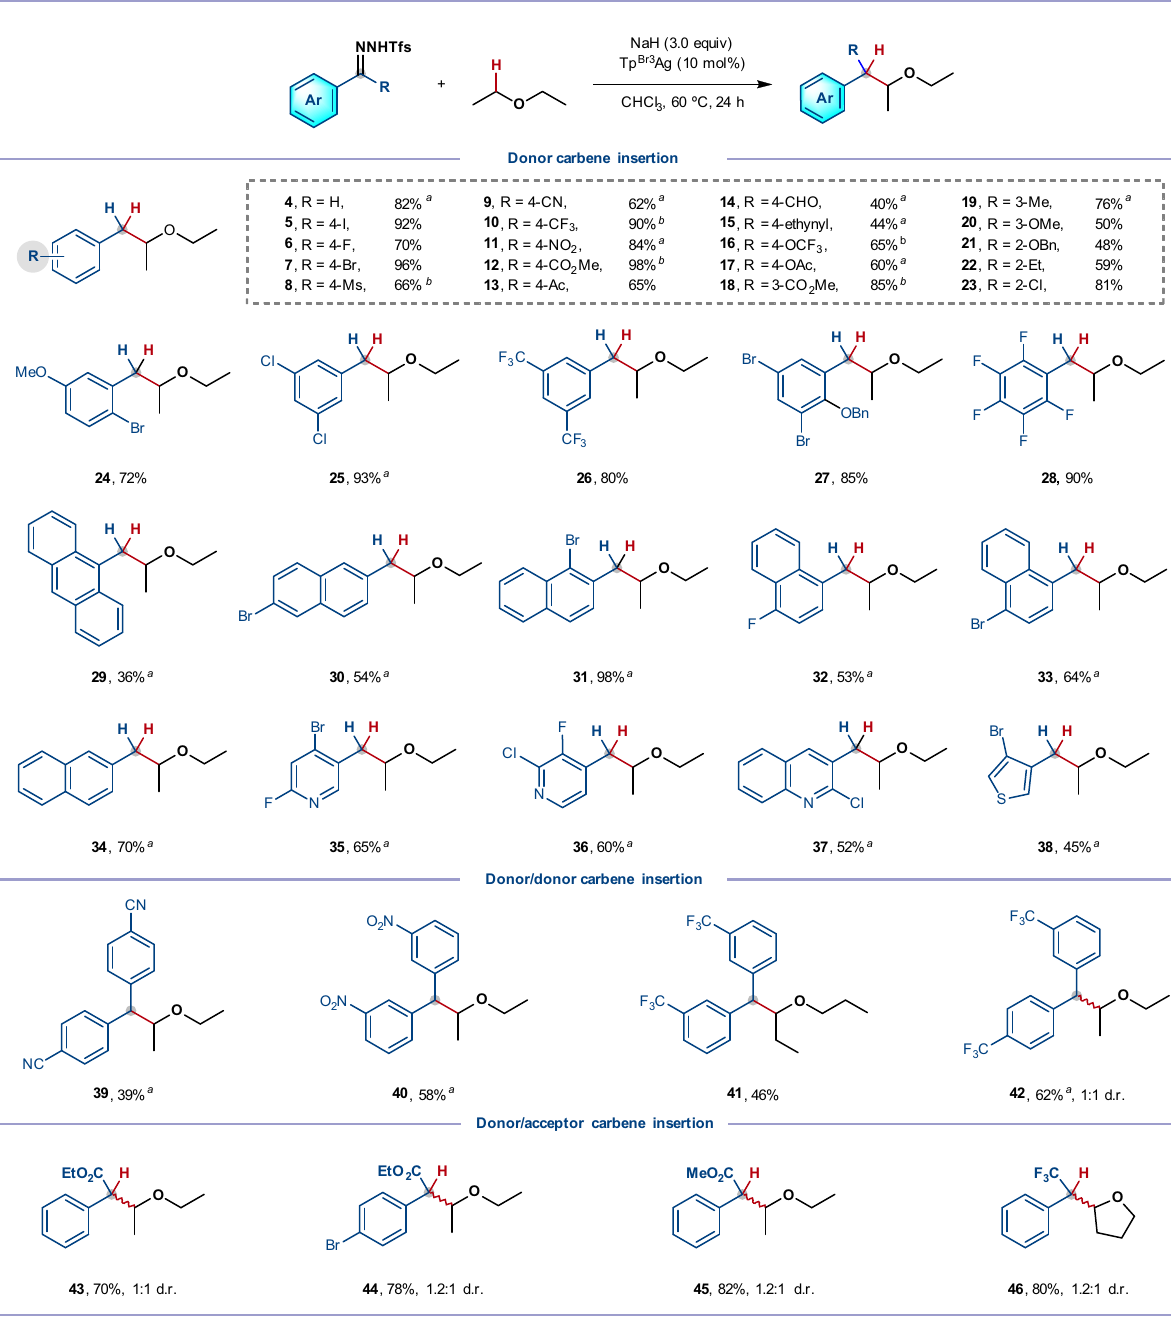
Fig. 3 Substrate scope with respective to N -triftosylhydrazones. Standard conditions: N -Triftosylhydrazone (0.3 mmol), ether (1.0 mL), NaH (0.9 mmol, 3.0 equiv), Tp Br3 Ag (10 mol%), CHCl 3 (5.0 mL), under argon atmosphere at 60 °C for 24 h, isolated yield. a Ether (5.0 mL) was used. b PhCF 3 (5.0 mL) was used. Ms, methylsulfonyl; Bn, benzyl; Ac, acetyl; d.r., diastereomeric